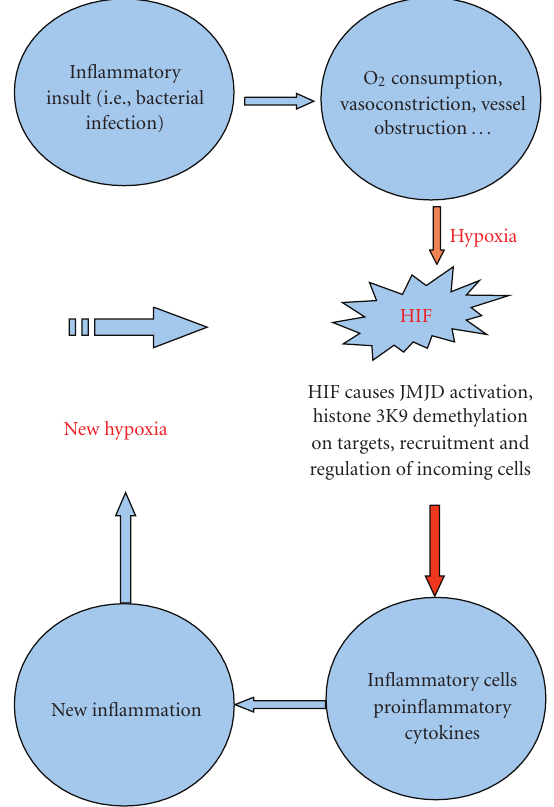
Figure 1: A vicious circuit could be established when HIF-1 activates, on recruited inflammatory cells, specific cytokines, such as IL-10, TNF, HIF1 (on macrophages in particular), or IL-4, IL13 (from mastocytes, eosinophils, or other cells). This event would create new inflammation followed by new hypoxia